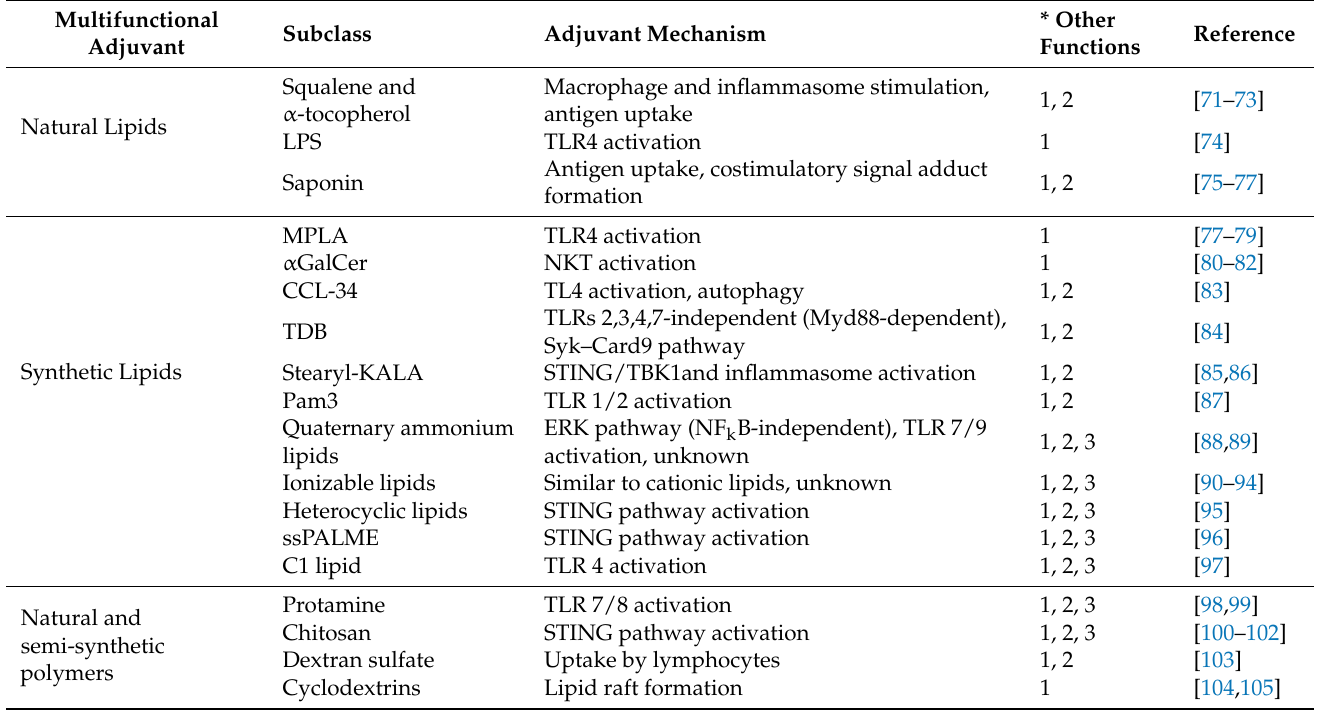
Table 1. List of multifunctional immunoadjuvants for incorporation in nucleic acid vaccines. Multifunctional